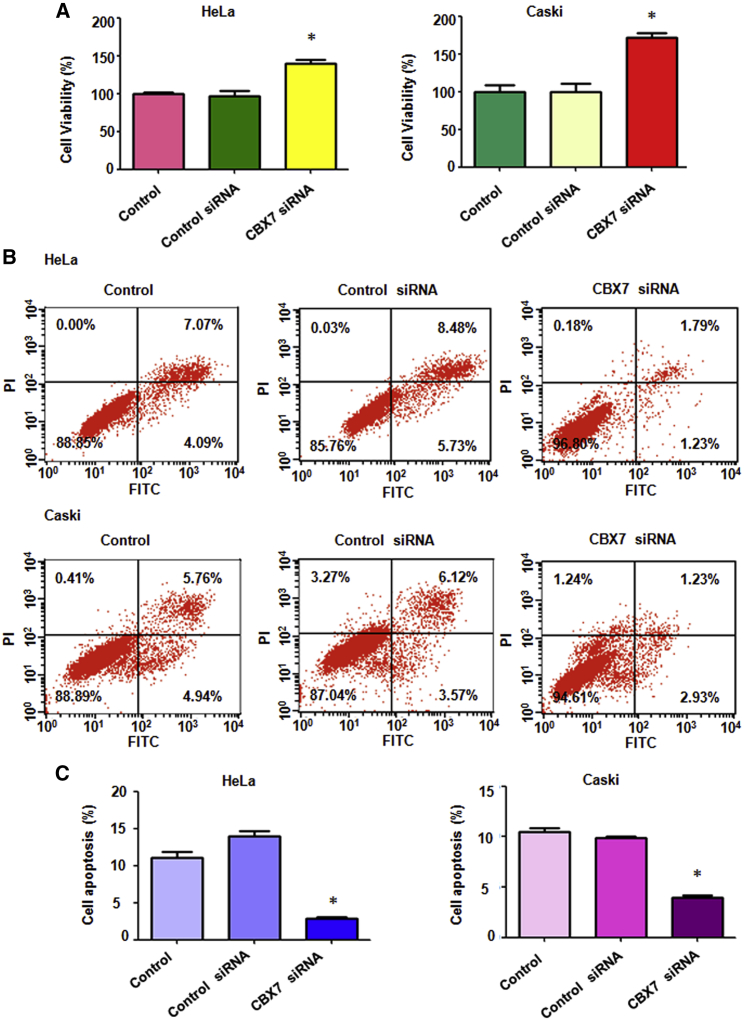
Downregulation of CBX7 Promotes Cell Proliferation and Inhibits Apoptosis(A) Cell viability was measured by MTT in both HeLa and Caski cells with CBX7 siRNA transfection at 72 h. *p < 0.05 versus control group. (B) Cell apoptosis was determined by flow cytometry in cervical cancer cells with CBX7 siRNA transfection at 72 h. (C) Quantitative results are illustrated for cell apoptosis.